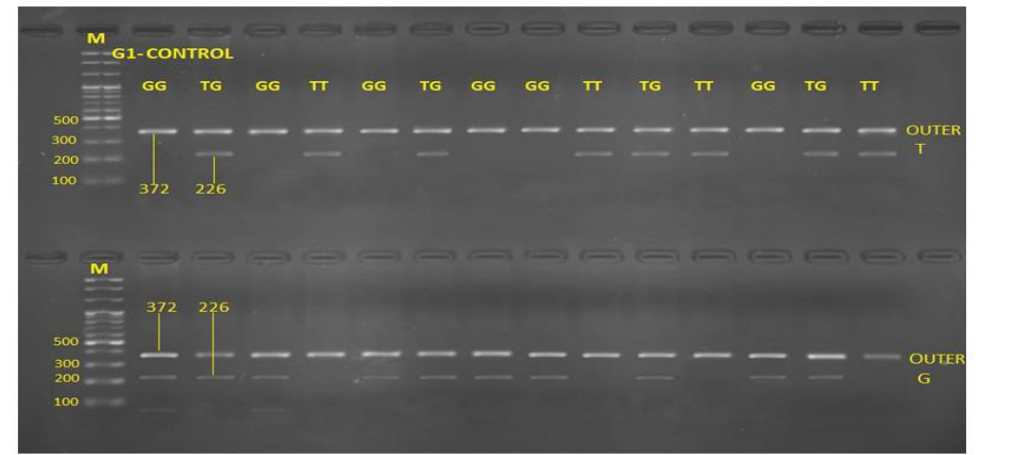
Fig. 1. Gel electrophoresis of ADIPOQ (rs 2241766) gene polymorphism amplified with a specific pair of primers using conventional PCR for control group (G1). M: DNA ladder (100-3000 bp). The PCR products were stained with safe stain dye. homozygous TT genotypes (372 and 226 bp) of FT; heterozygous TG genotypes (372, 226, and 226 bp) of FT+FG; homozygous GG genotypes (226 bp) of FG. 3.1.2. The Genotype of the ADIPOQ (rs 2241766) Gene in diabetes mellitus (G2) group that are shown in Table (3.1) the Type 2 Diabetes Mellitus Group (G2) are calculated from “Figure 2”. The genotype frequencies and allele distributions of rs 2241766 polymorphisms of ADIPOQ gene for the Type 2